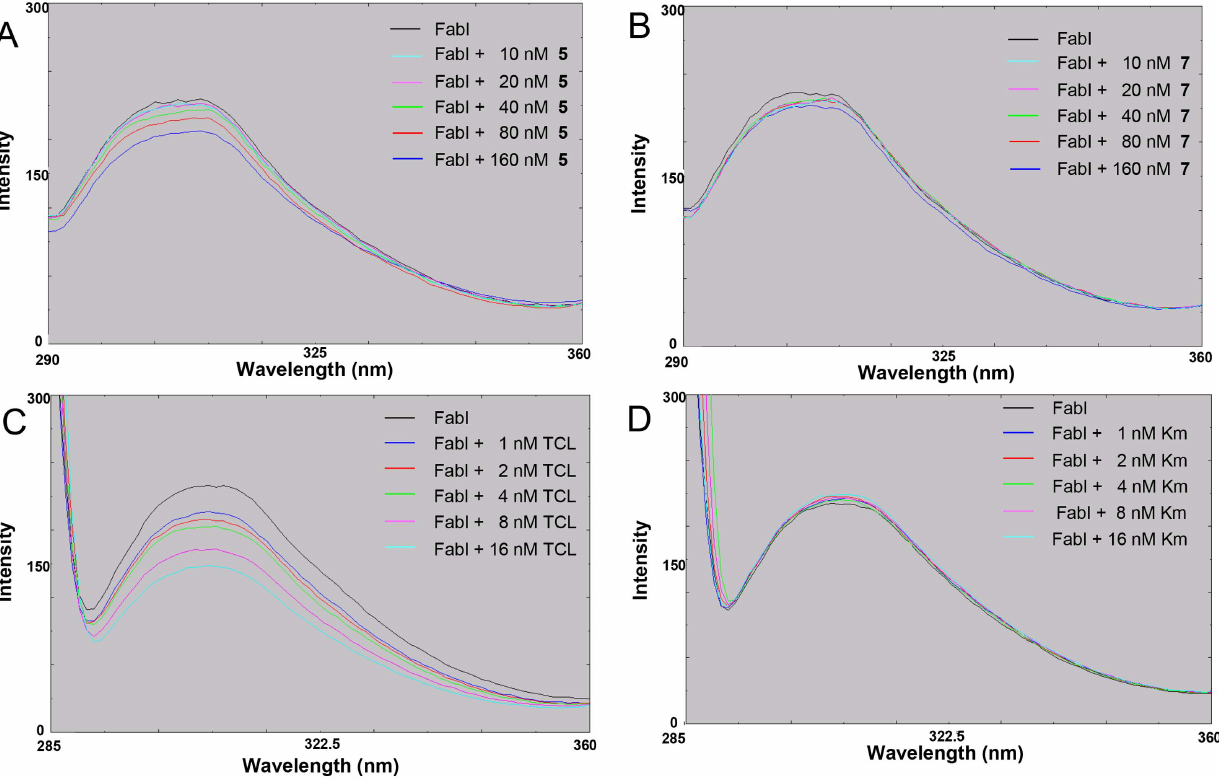
Figure 3. Direct binding of the derivatives of meleagrin with Staphylococcusaureus FabI by fluorescence quenching assay. (A) The more active derivative ( 5 ), (B) The inactive derivative ( 7 ), (C) triclosan (TCL) as a positive control, and (D) kanamycin (Km) as a negative control.